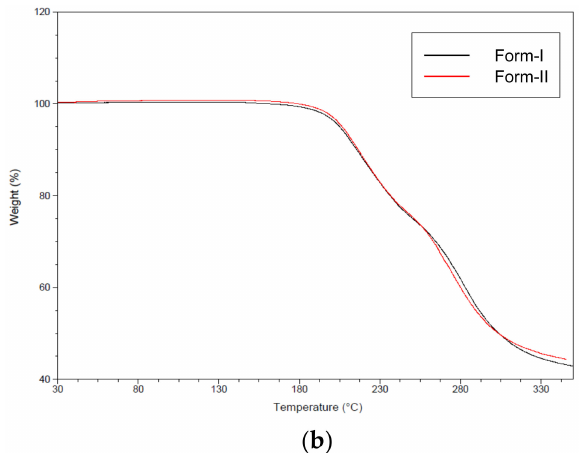
Figure 7. Results of thermal analysis of CO polymorphs (10 ◦ C/min): ( a ) Differential Scanning Calorimetry (DSC), ( b ) Thermogravimetric Analysis